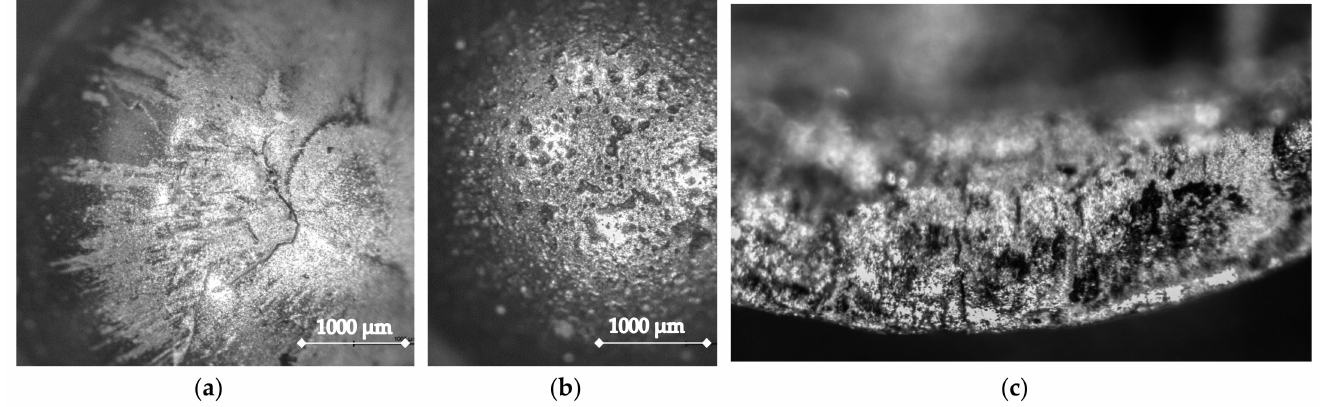
Figure 3. Photographs of magnified ball bearing damage on ( a ) Face A, ( b ) Face B, ( c ) the cracked region (5.13 g PE4, 18 mm charge diameter, 5 mm diameter ball